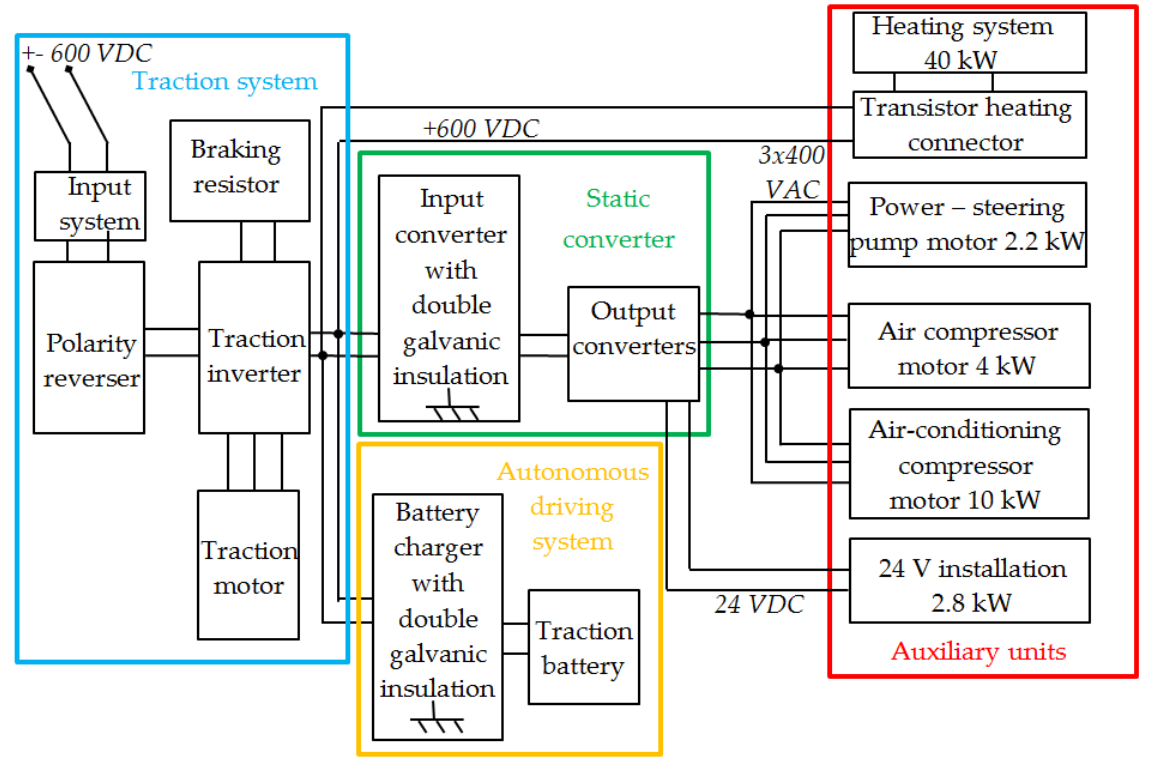
Figure 4. Block diagram of power supply to trolleybus drive and its auxiliary devices [21].